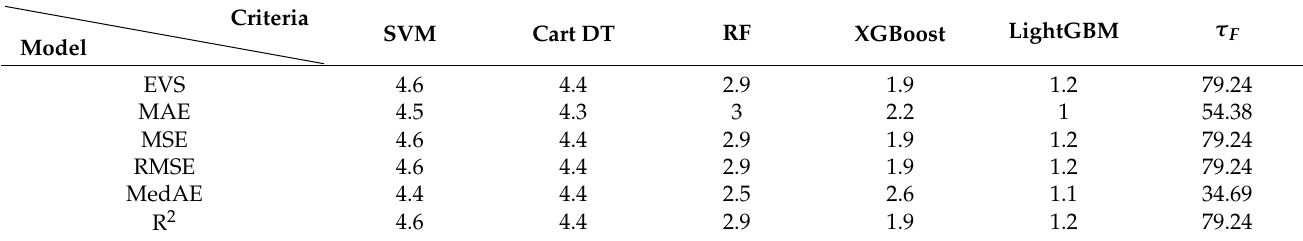
Figure 15. Prediction performances of five machine learning models on test set under different evaluation criteria: ( a ) The lower the criteria value, the better the model performance; ( b ) The higher the criteria value, the better the model performance. The data types presented in ( a , b ) are the results of the test set under each regression indicators in Table 5. The length of the histogram represents evaluation value, reflecting the difference between the predicted value and the true value. Table 6. The average ordinal value of each algorithm and Friedman statistics.